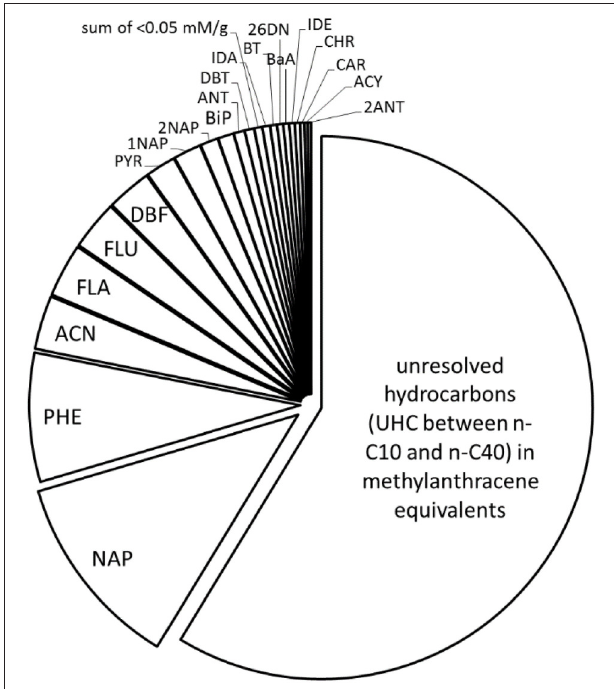
FIGURE 3 | Stoichiometric DNAPL composition, based on quantitation via GC-MS and GC-FID. Molar fractions of 1PNA, BhQ, BbF, BaP, PHO, PHI, BkF, and ACR were below 0.05mM/g and are displayed as their sum, and unresolved hydrocarbons eluting between n -C 10 and n -C 40 were converted to equivalents of